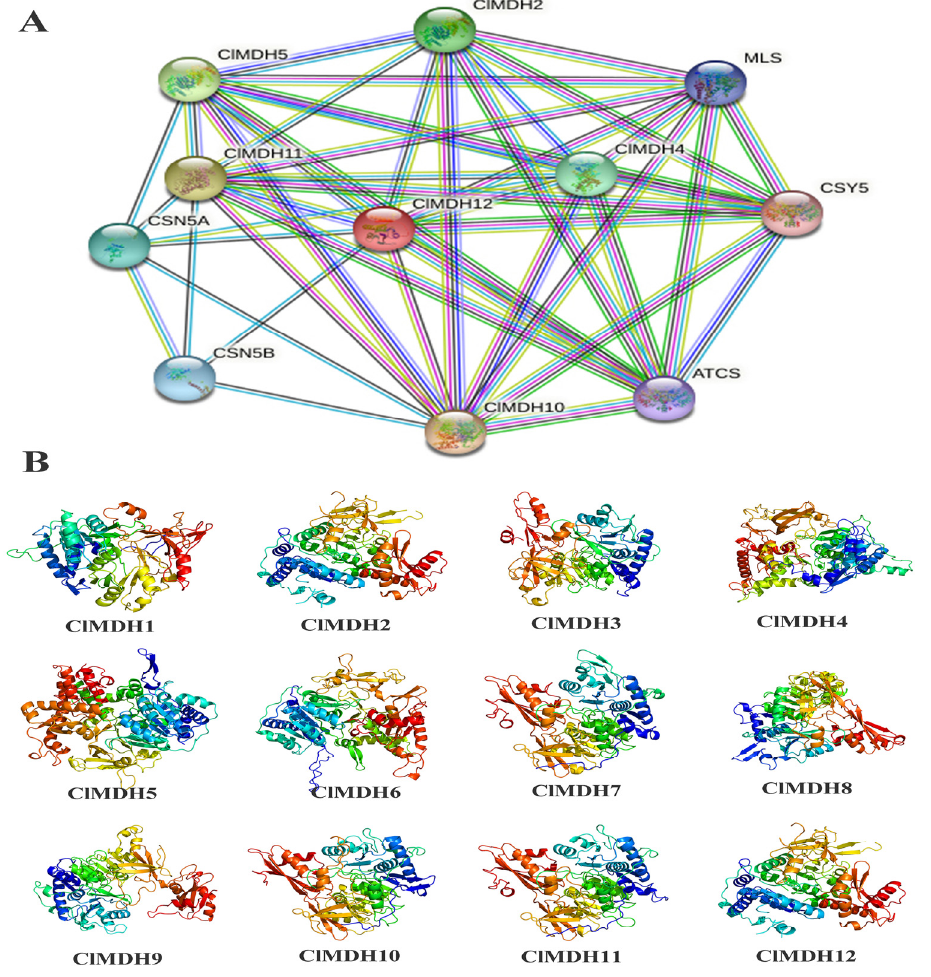
Figure 7. Protein–protein interaction and predicted 3D models of ClMDH proteins. ( A ) High confidence interaction (0.7). ( B ) 3D models of ClMDH proteins were constructed using the online Phyre2 server with intensive mode.